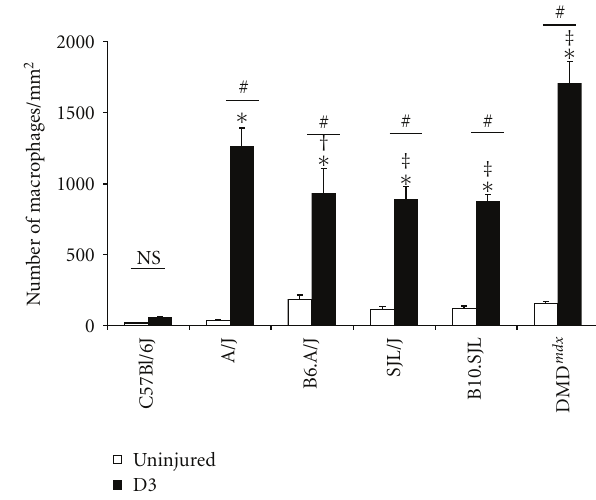
Figure 8: Quantitation of macrophages (CD68+ cells). We counted macrophages in cross sections of uninjured and injured TA labeled with antibodies to CD68 (see Figure 4). All dysferlin mutant strains showed elevated macrophage counts at D3 post-LSI, with A/J having significantly higher levels than the other strains. DMD mdx muscle showed significantly higher macrophage infiltration than A/J. ∗ Significant di ff erence compared to control strain at same time point. # Significant di ff erence within same strain between uninjured and D3. † Significant di ff erence compared to same Dysf mutation at same time point. ‡ Significant di ff erence compared to A/J at same time